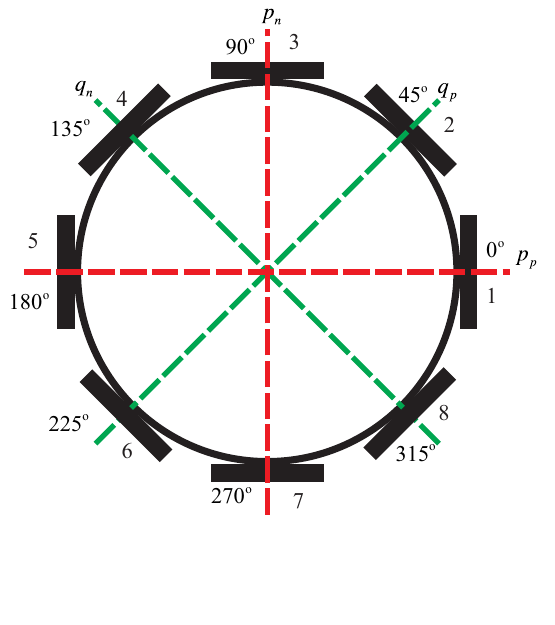
Figure 12. The transversal surface of the standing